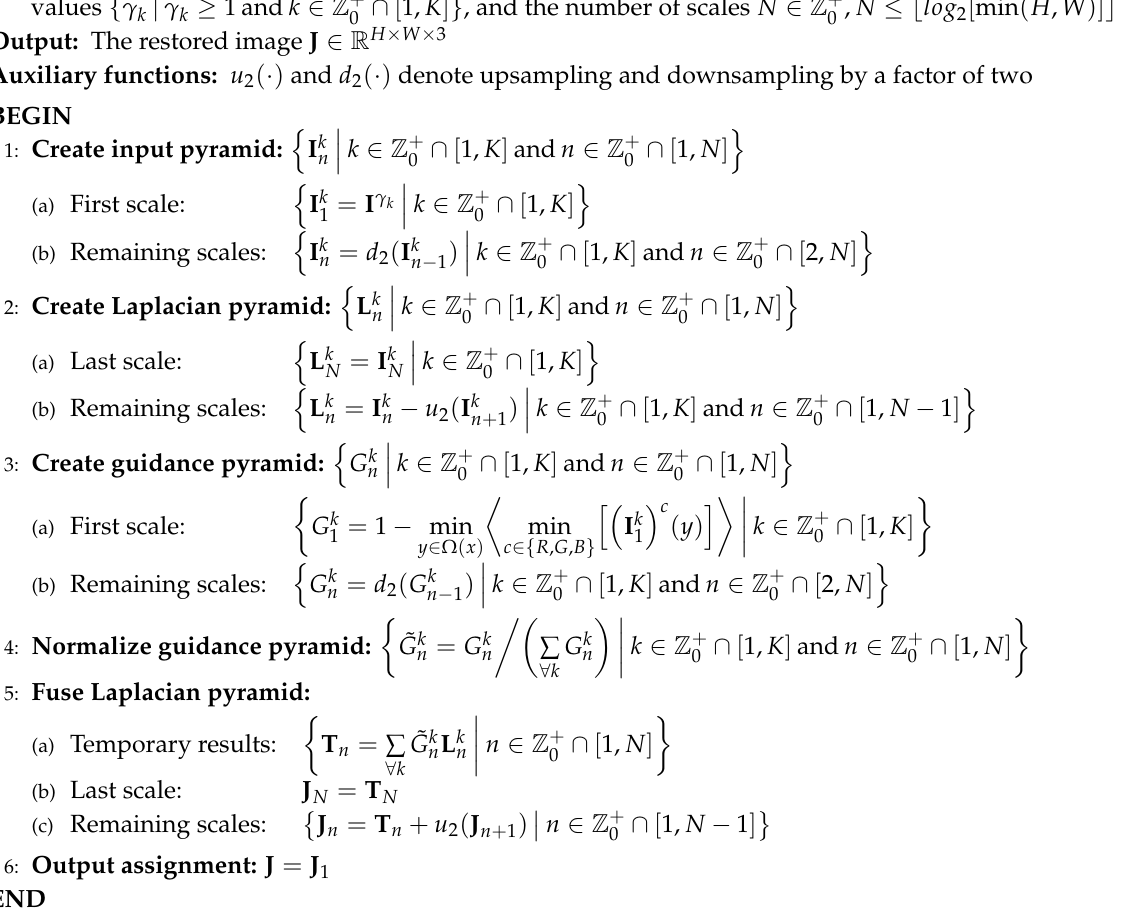
Algorithm 1 Multi-scale image